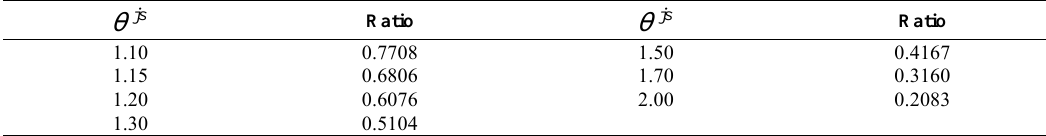
Table 8. Ratio of 1-link connected N/Ds to total